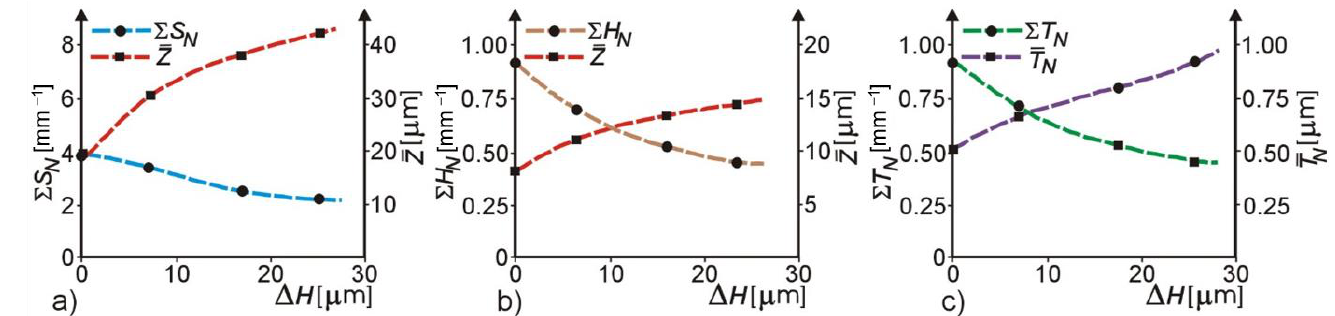
Figure 12. The stereometric parameters CSGW in ECDGW-AC process: ( a ) Static cutting edges; ( b ) Kinematic cutting edges; ( c ) Maximum chip thickness; Grinding conditions: V GW = 25 m/s, V f = 5 m/min, a = 0.02 mm; Dressing conditions: V GW = 25 m/s, i = 6 A/cm 2 , U e = 18.7